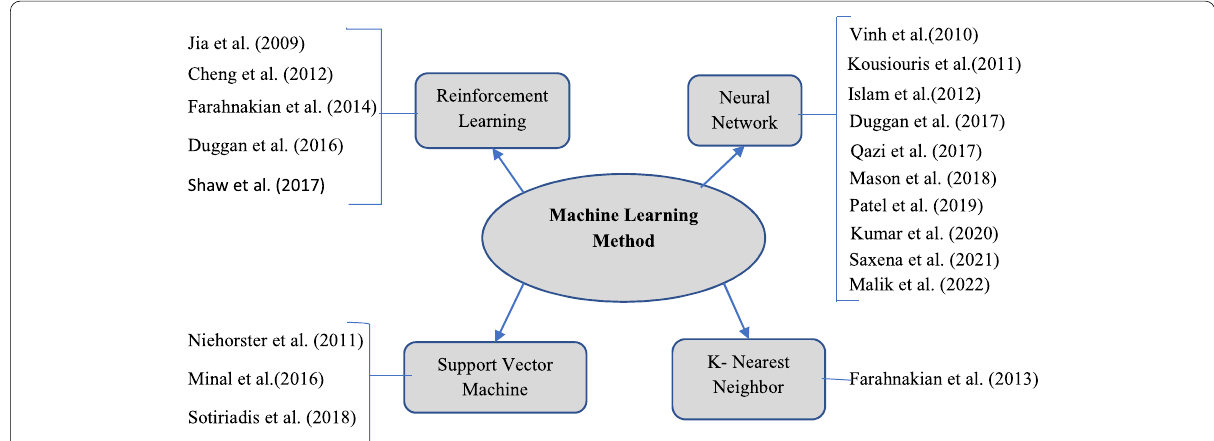
Fig. 8 Classification of existing research using a Machine learning method